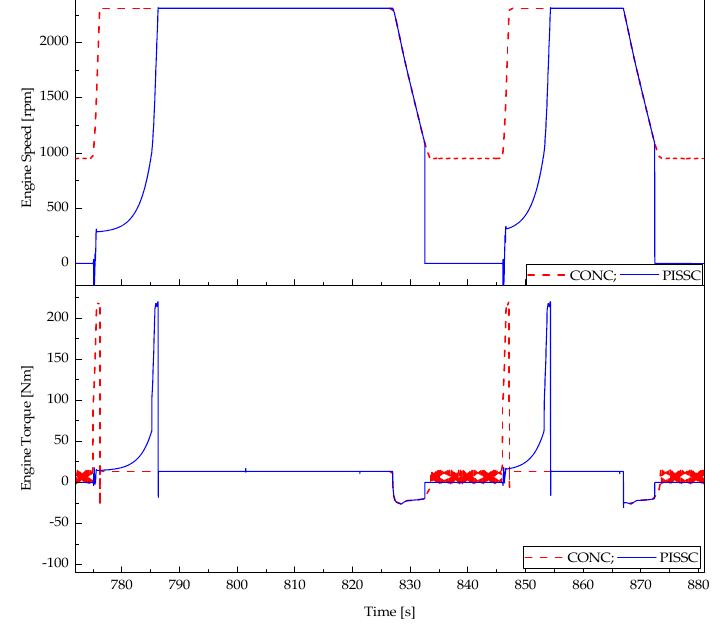
Figure 18. Simulated ICE dynamics from the 7th cycle —stage 16 to the 8th cycle—stage 15.